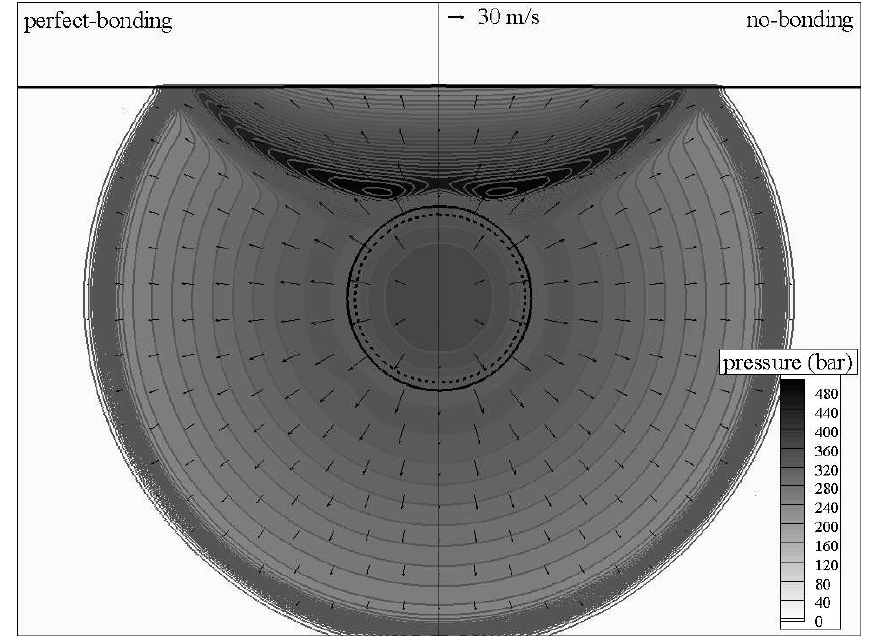
Fig. 11. Comparison of the fluid fields at t = 0 . 4 ms between the perfect- and no-bonding sandwich plates with clamped